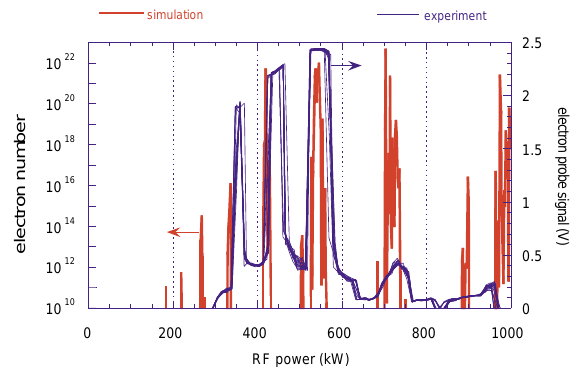
FIG. 2. (Color) Measured and simulated electron activity on the upstream side of the l (cid:3) 2 window.